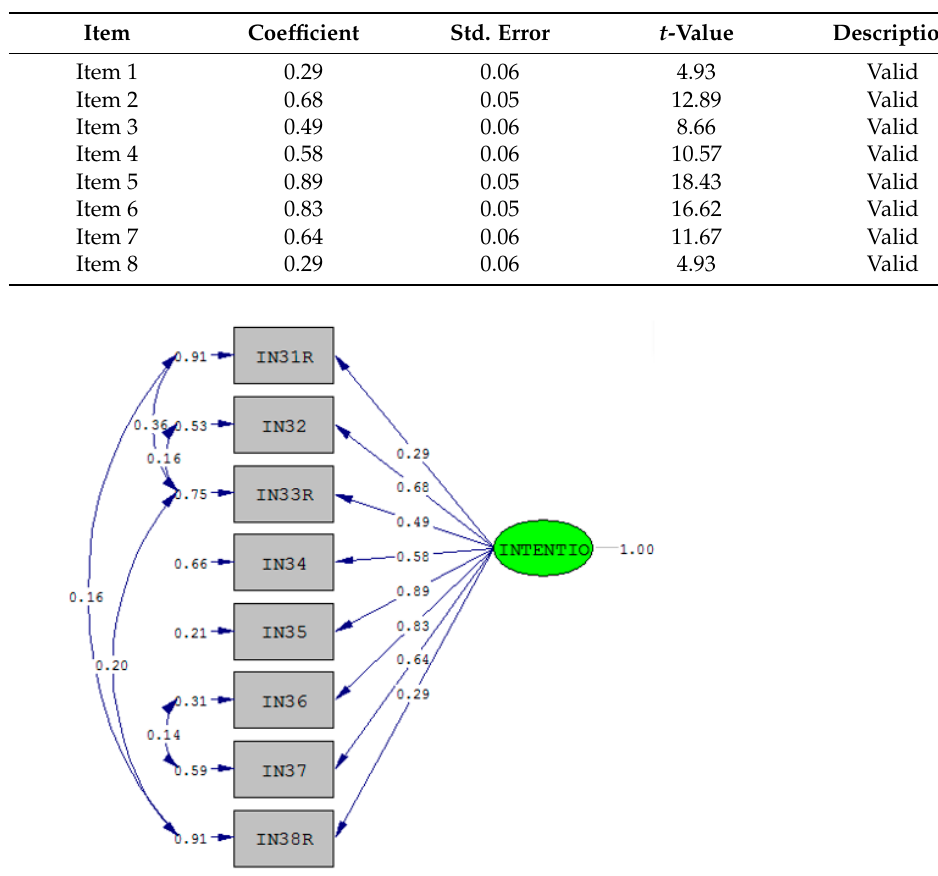
Table 4. Results of CFA of the Islamic Religious Moderation Intentions Scale.